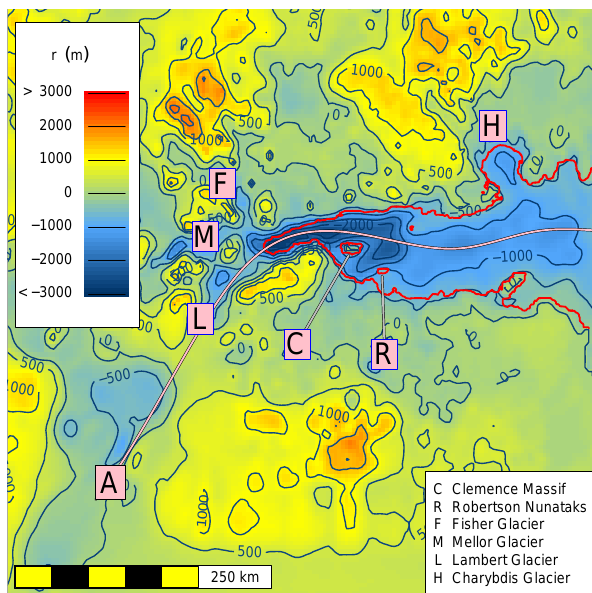
Figure 1. ALBMAP bedrock topography in the region of the Amery Ice Shelf. The grounding line (red curve) lies on a downward slope along its entire length. The Lambert, Fisher, and Mellor glaciers converge and join the ice shelf at its southern end. The curve marked “A” follows Lambert Glacier onto the ice shelf and is used for cross- section plots in Fig.